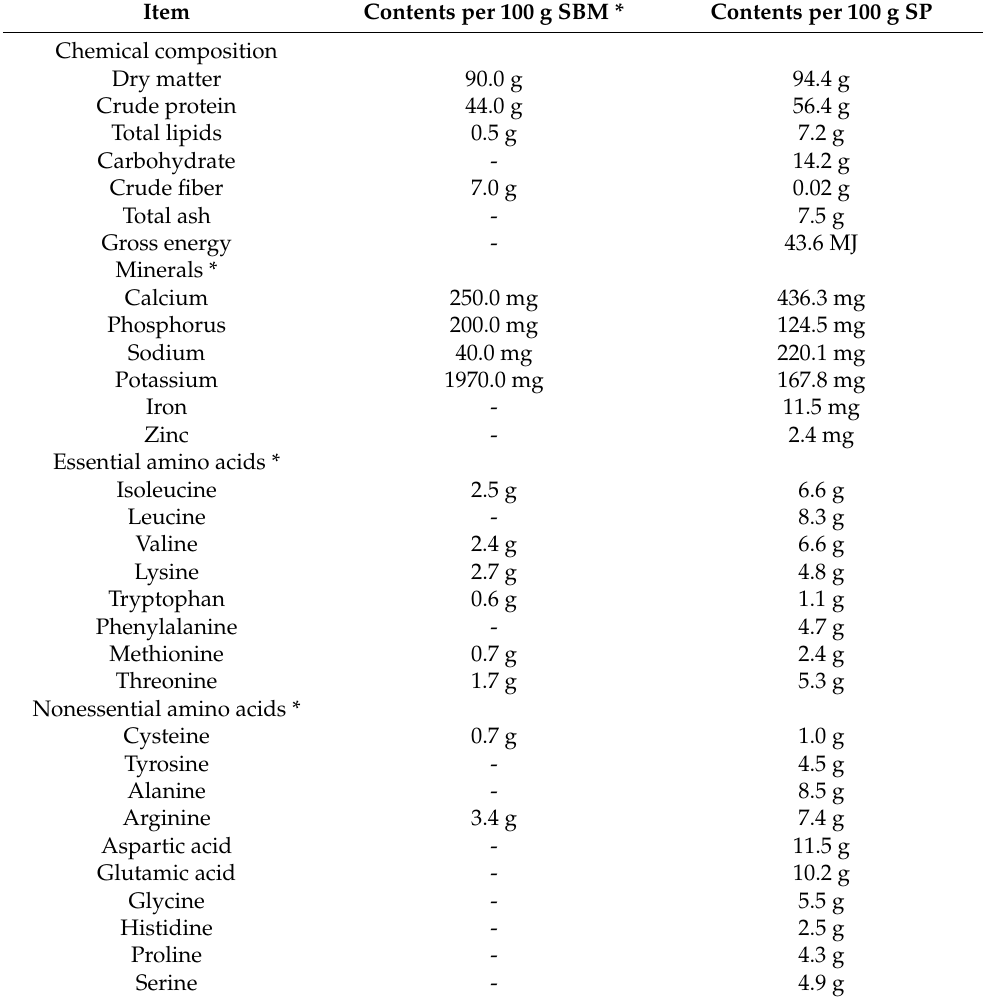
Table 1. The chemical analysis of soybean meal (SBM) and Spirulina platensisis (SP).